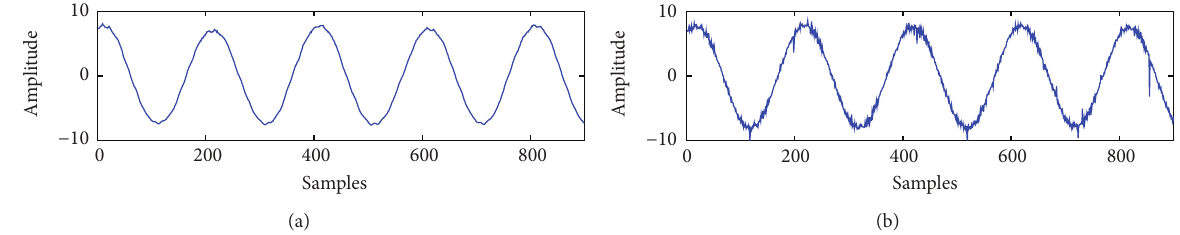
Figure 6: 50 Hz stator current signal from the (a) main-fed and (b) inverter-fed healthy squirrel-cage motor.